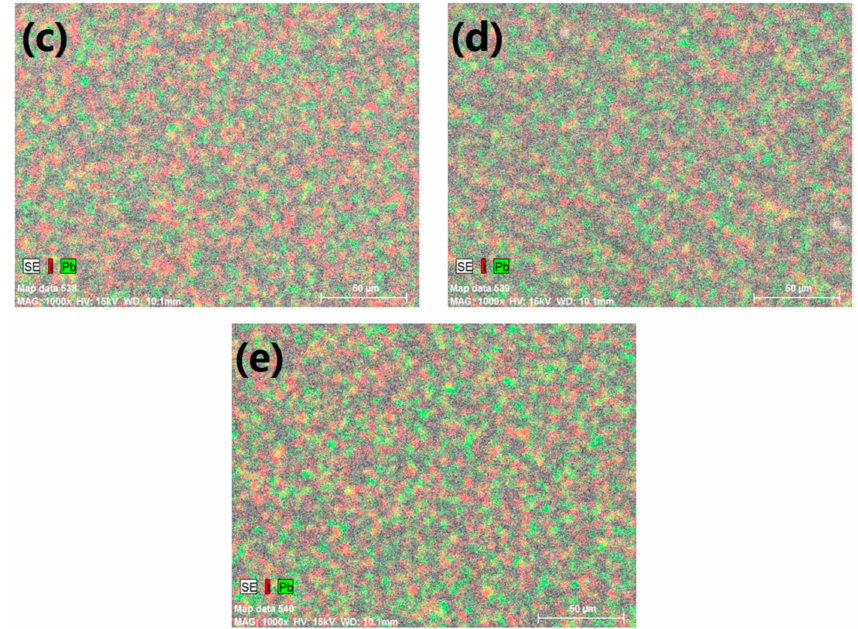
Figure 5. Distribution of Pb and I elements of A, B, C, D and E regions of large-area MAPbI 3 thin films: